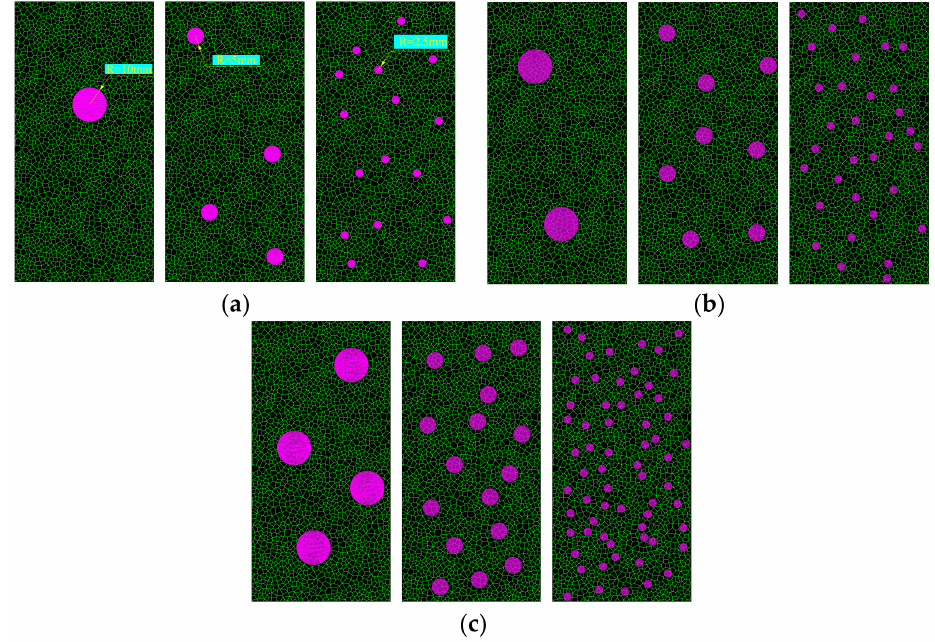
Figure 11. Mineral ratios for models under single circular dimensions 10, 5 and 2.5 mm: ( a ) S1–S3: 2.45%; ( b ) S4–S6: 4.9%; ( c ) S7–S9: